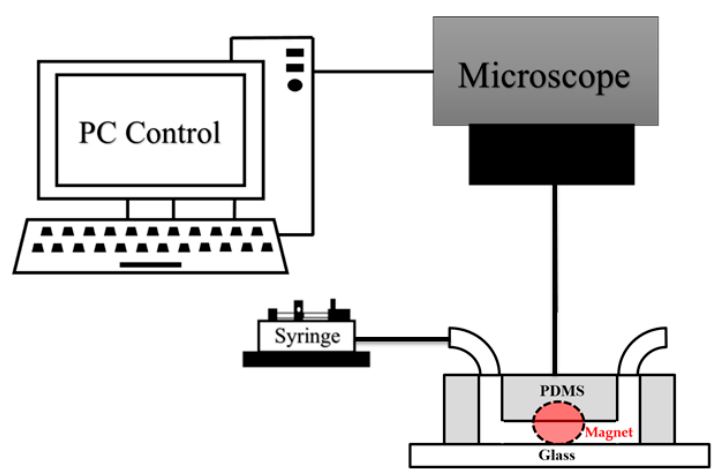
Figure 2. Experimental setup of the isolation system.